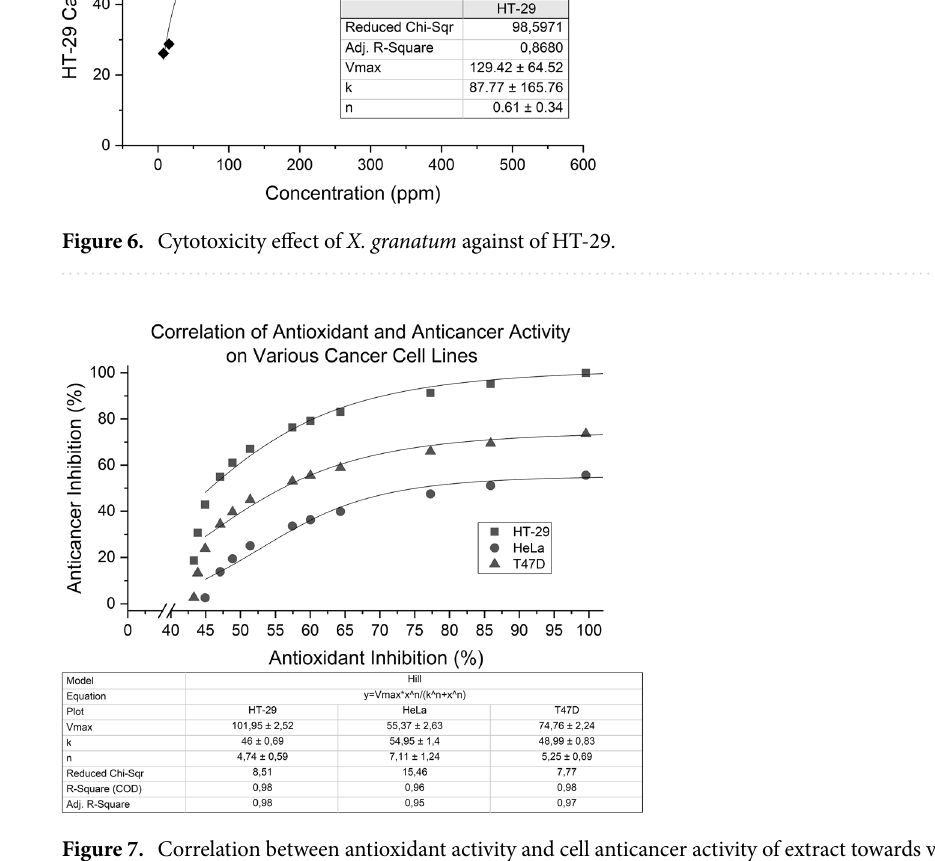
Figure 7. Correlation between antioxidant activity and cell anticancer activity of extract towards various cancer cell